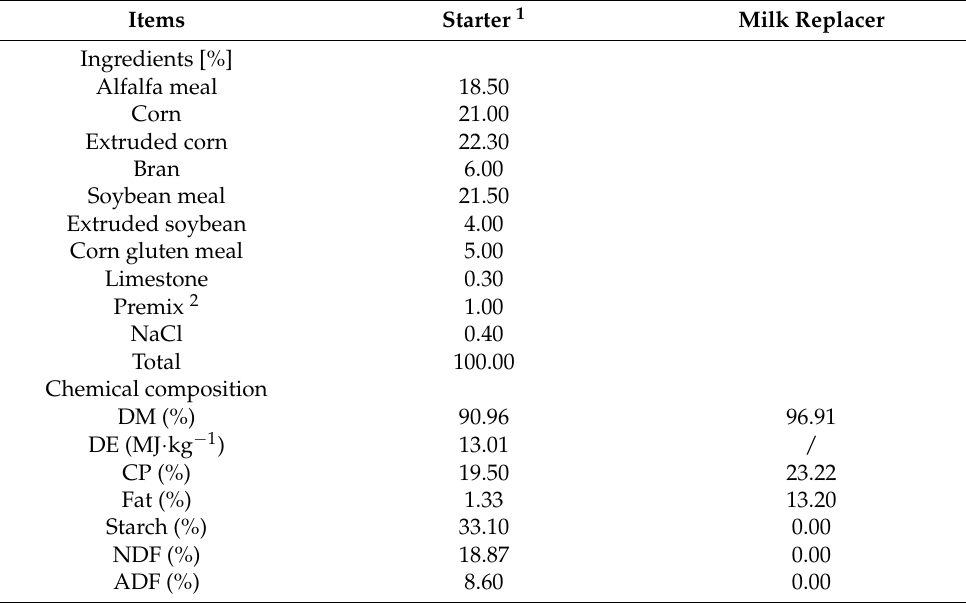
Table 1. Ingredients and chemical composition of starter diet and milk replacer (air-dried